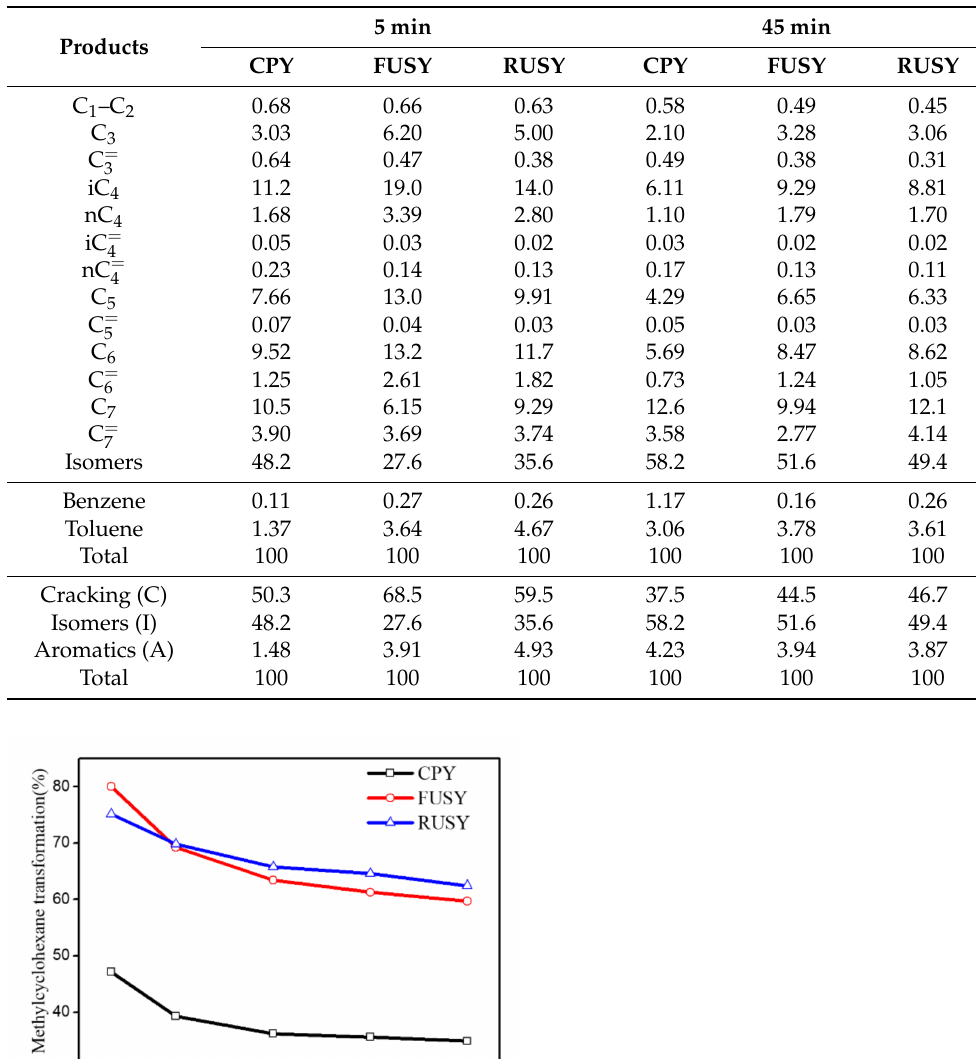
Table 3. Product distributions at a reaction time of 5 and 45 min over the three Y-zeolite samples.